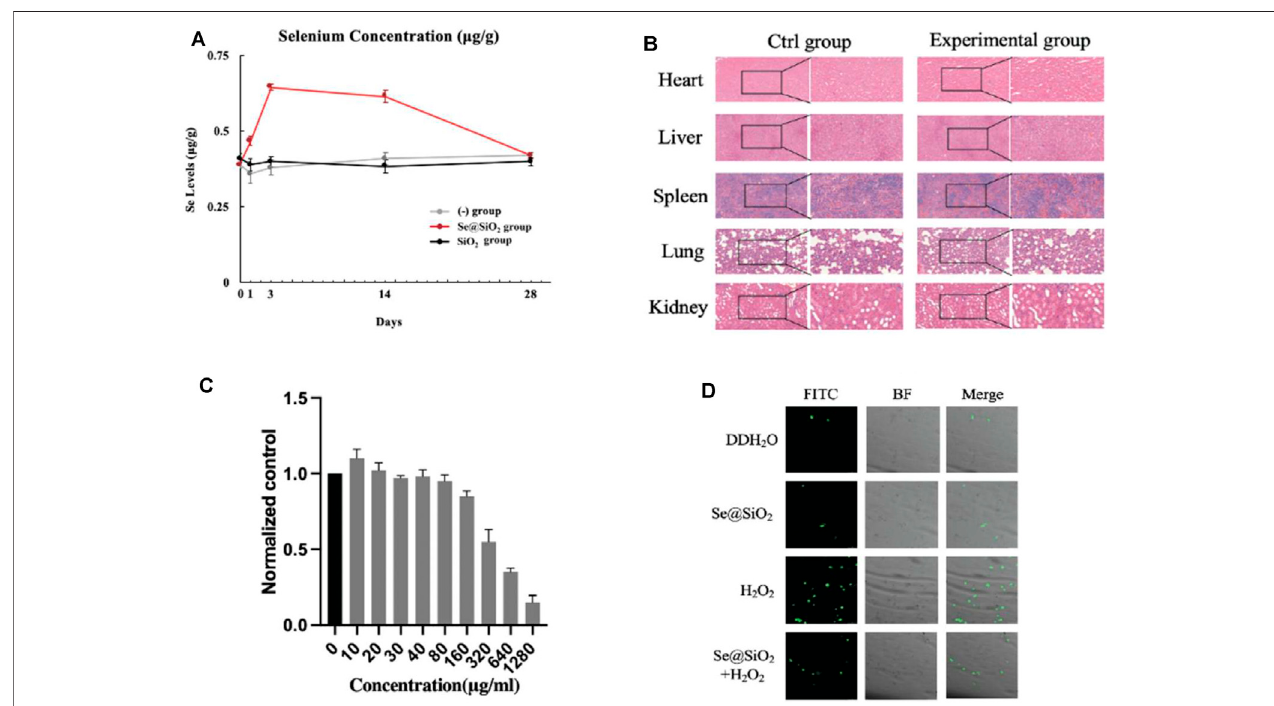
FIGURE 3 | Release pro fi le, biosafety and oxidation resistance of Se@SiO 2 NPs in vivo and vitro. (A) ICP-AES de fi ned the Se contents in regenerated tissues of dermal wound at each time point. (B) Histological analysis of the heart, liver, spleen, lung and kidney tissues of rats at 4 weeks after the in vivo models were established (scalebars:50 μ m)(200×and400×). (C) TheviabilityofHSFswasdetectedafter24 hofcoculturewithdifferentconcentrationsofporousSe@SiO 2 nanoparticlesusinga CCK-8 assay. (D) ROS expression was demonstrated by FITC images, BF images and merged views combining BF and FITC images using a DCFH-DA assay observed by confocal microscopy. * p < 0.05, ** p < 0.01 and *** p < 0.001. Abbreviations: ICP-AES, inductively coupled plasma atomic emission spectroscopy; HSFs, human scar fi broblasts cell line; CCK-8, Cell Counting Kit-8; ROS, reactive oxygen species; FITC, fl uorescein isothiocyanate; BF, bright fi eld; DCFH-DA, 2 ′ ,7 ′ - dichlorodihydro fl uorescein